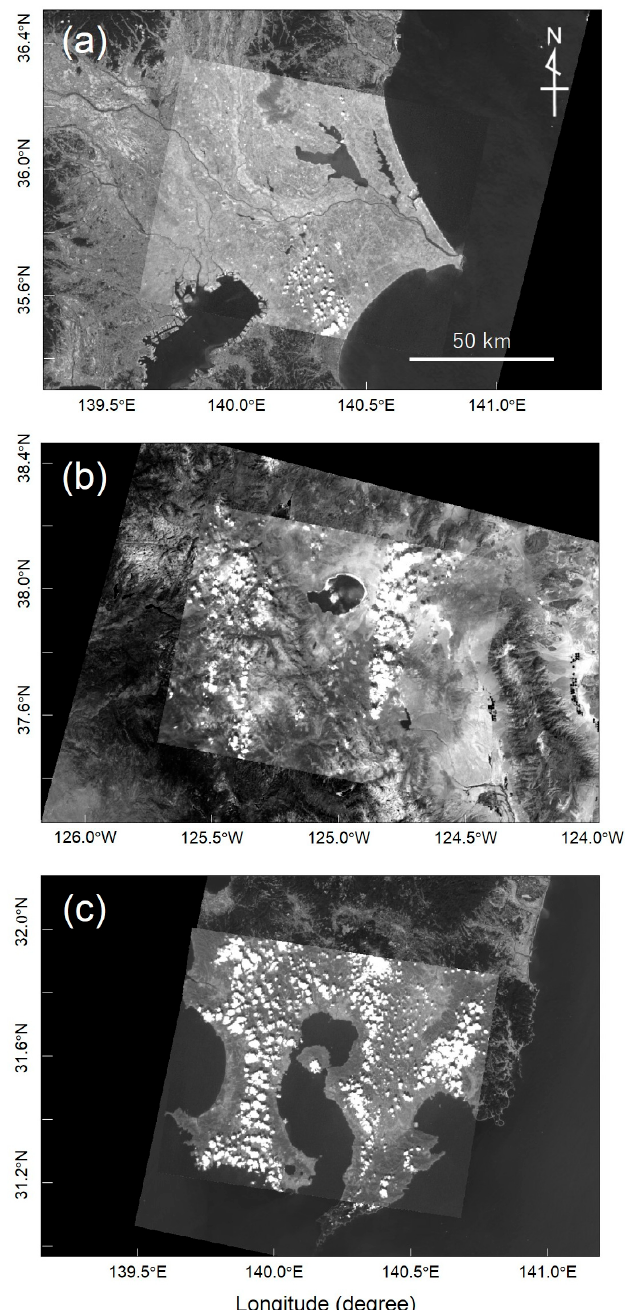
Figure 7. Map projection of UNIFORM-1 images onto latitude–longitude coordinates using the satellite attitude determined by the proposed scheme for ( a ) the less cloudy (Kanto, Japan), ( b ) the moderately cloudy (Yosemite, US), and ( c ) the many cloud-patch (Kyushu, Japan) cases as shown in Figure 4. Background base images are from Landsat-8 OLI. Contrasts in the VIS images are enhanced.